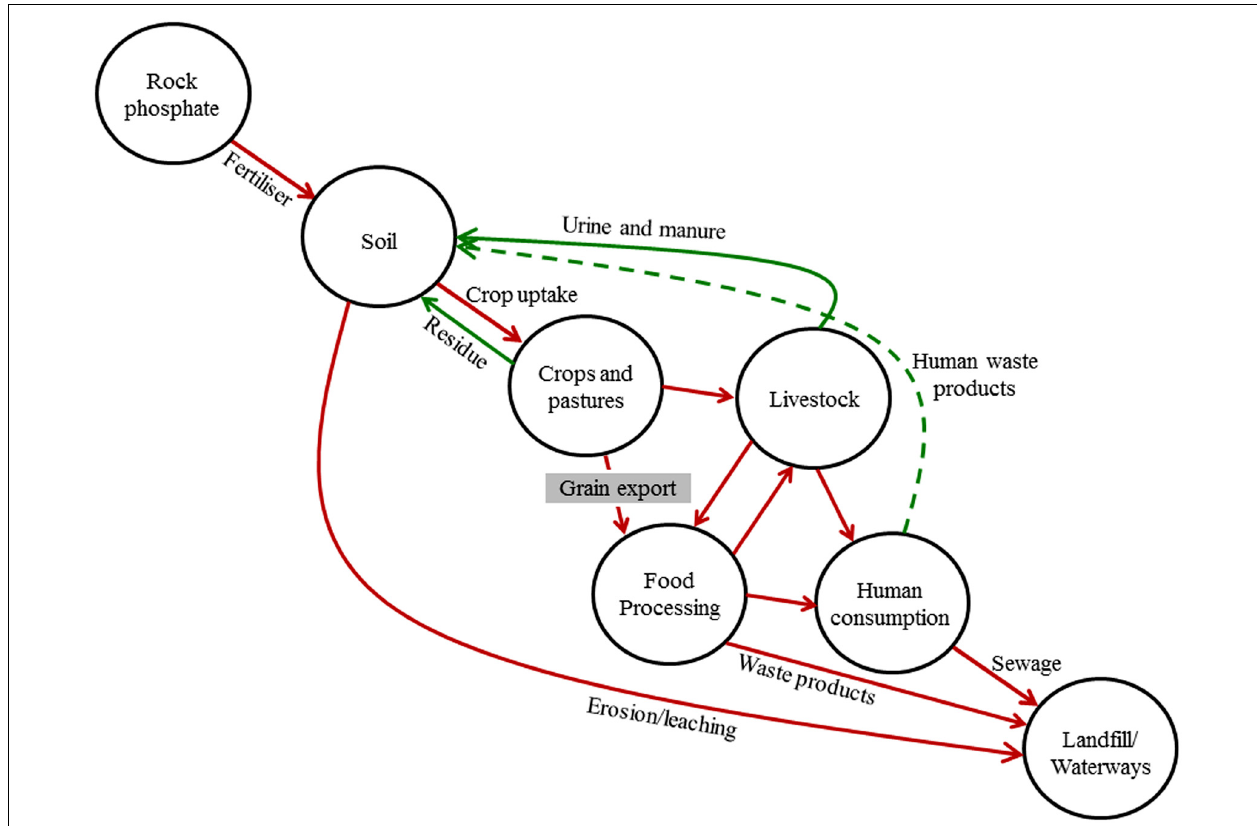
FIGURE 1 | Major flows of phosphorus in the global agricultural phosphorus cycle. Broken green line indicates a major break in the cycle due to poor recovery and recycling of human waste; gray box indicates potential point to slow the flow of P through agricultural systems.